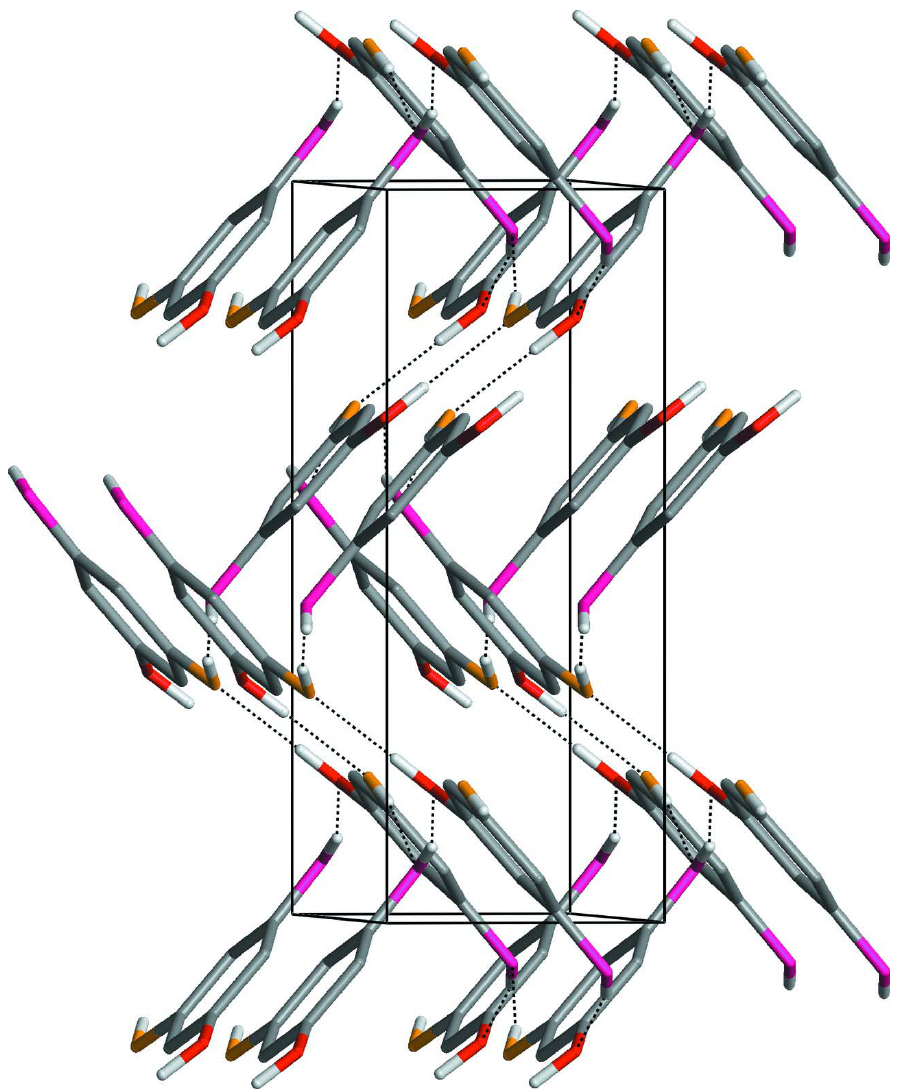
Figure 2 Molecular packing and unit cell of the title compound viewed along the b axis. Hydrogen bonding is indicated by dashed lines, H-atoms bonded to C have been omitted for clarity. The three different hydroxylic O atoms have been depicted in different